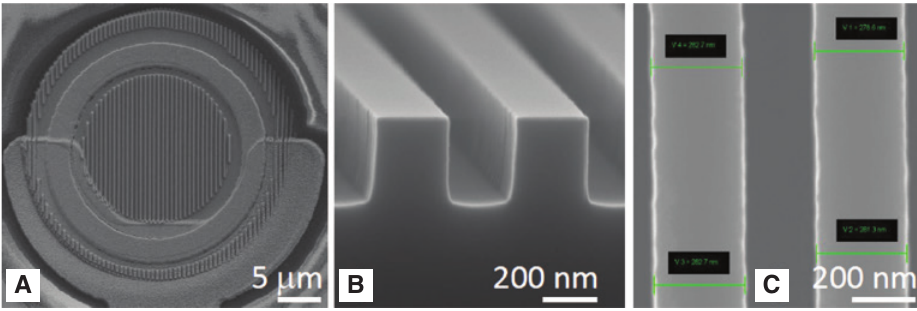
Figure 12: SEM images of a 980-nm M-D VCSEL. (A) Top-down view of the top p-metal ring and the emitting aperture showing also the MHCG stripes. (B) A focused ion beam (FIB) cross- section of two MHCG stripes. (C) Top-down surface view of two MHCG stripes.